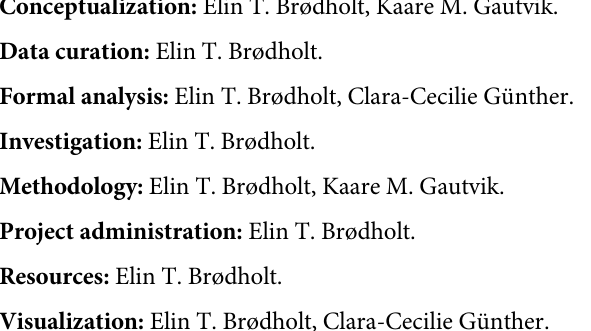
S1 Table. Data on age, sex, SES, BMD and stature for the total study sample.